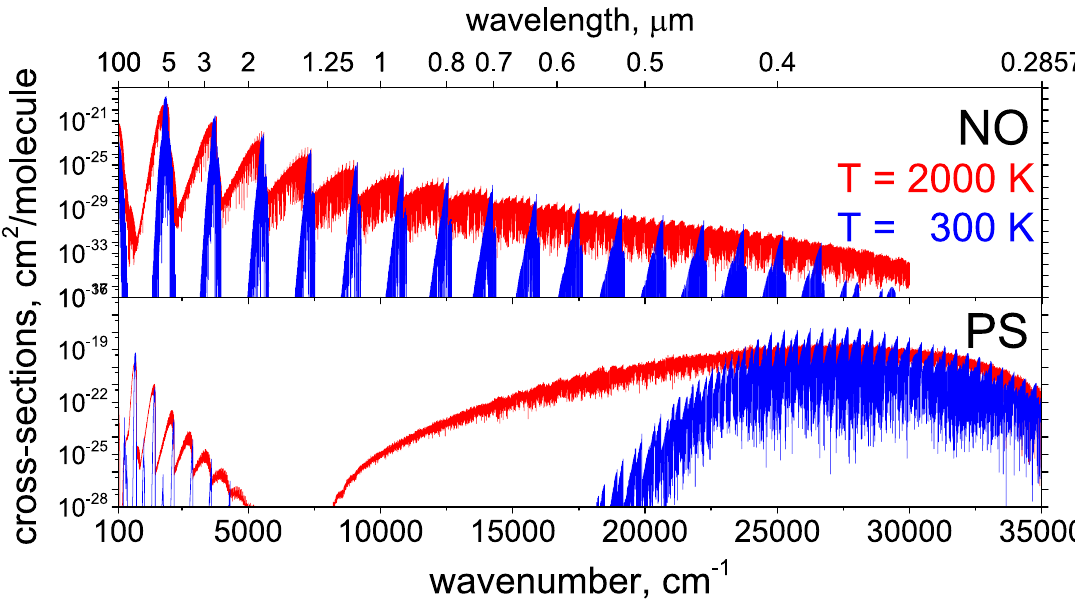
Figure 11. Cross sections generated from ExoMol line lists for nitric oxide [9] and phosphorous monosulfide